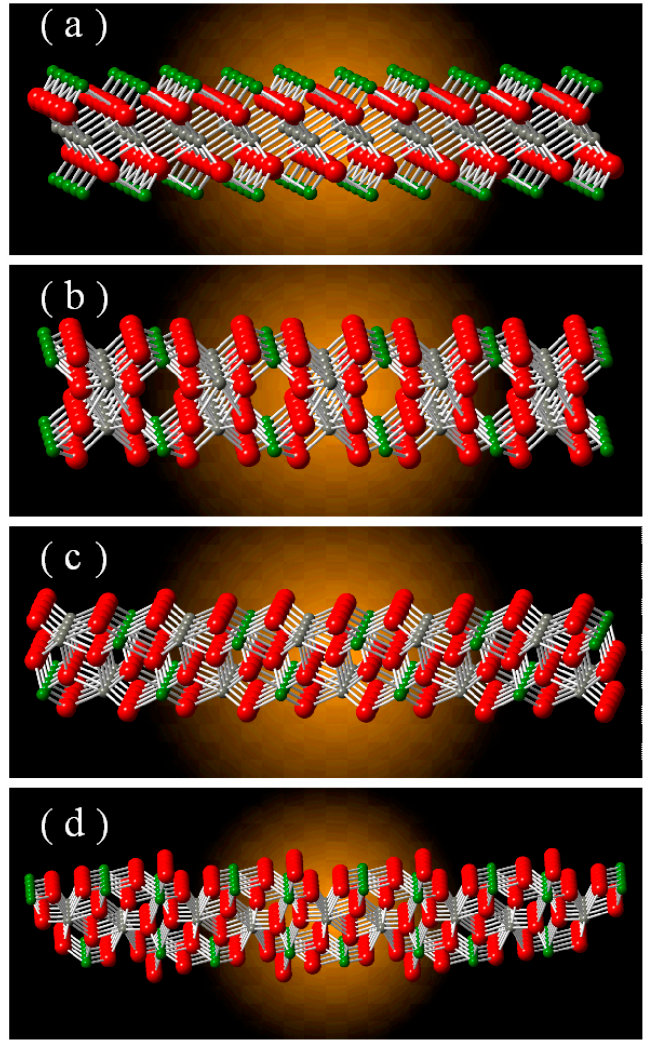
Figure 14. Schematic illustrations of the crystal structures on ZnWO 4 facets: ( a ) the {100} facet; ( b ) the {010} facet; ( c ) the {001} facet; and ( d ) the {011} facet. The O, W, and Zn atoms are shown in red, blue, and gray, respectively.